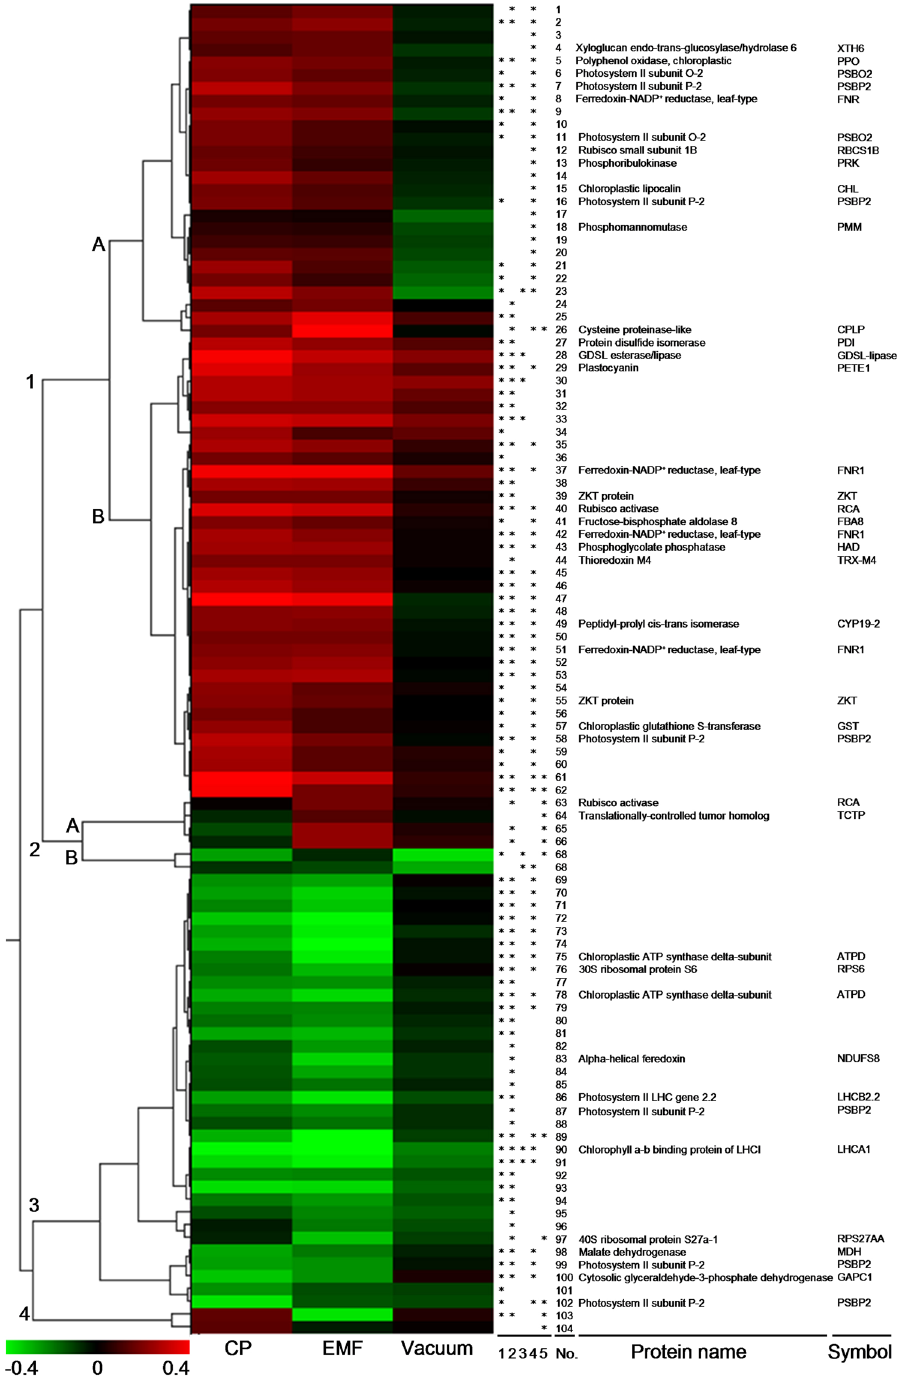
Figure 4. Hierarchical cluster analysis results of the abundance data of proteoforms differentially expressed in sunflower shoots germinated from the seeds treated with vacuum, CP or EMF radiation. Numbers on the left indicate four major clusters based on expression patterns. Colors indicate a decrease (green) or increase (red) in protein abundance compared to control. Star symbols in columns 1–5 indicate statistically significant (p < 0.01) differences between the cold plasma treatment and control (1), electromagnetic field treatment and control (2), vacuum treatment and control (3), cold plasma and vacuum treatment (4), and cold plasma and electromagnetic field treatment (5). Spot number and protein name are shown in column